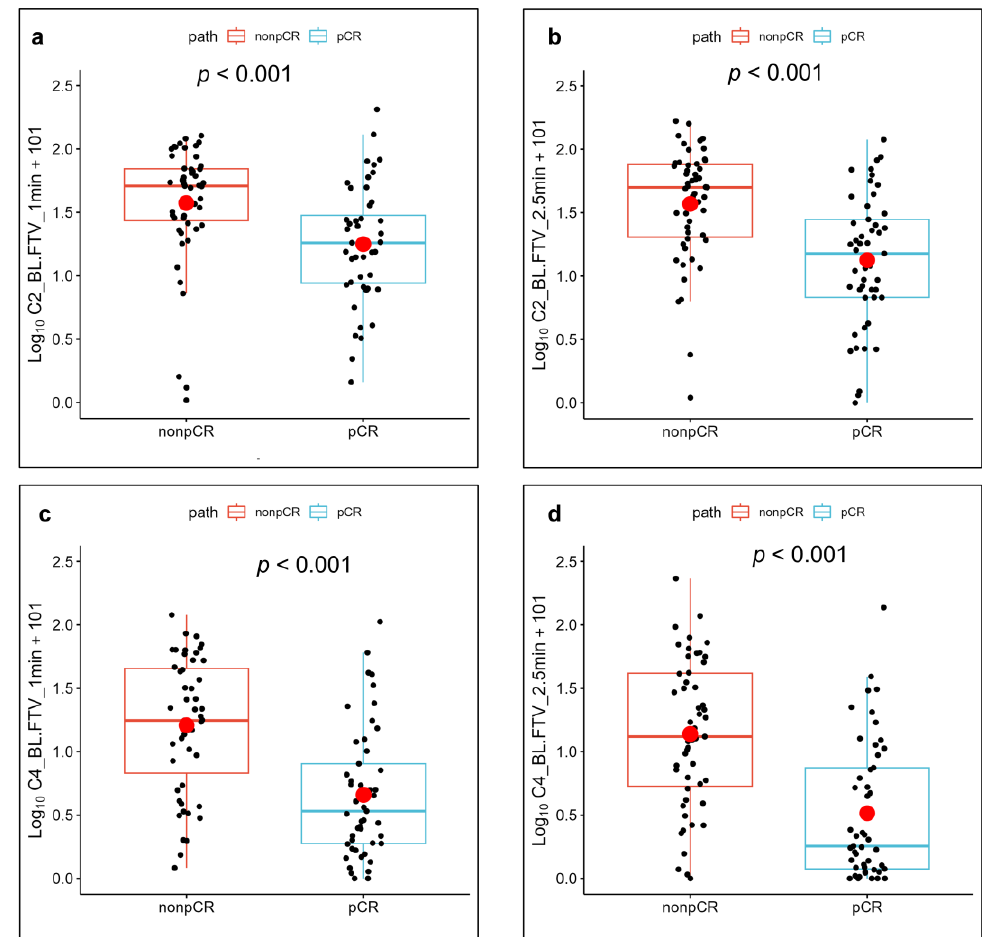
Figure 6. Relative changes in the functional tumor volume (FTV) measurements and their mean (red circle) corresponding to optimal percentage enhancement (PE) and signal enhancement ratio (SER) for patients with pathologic complete response (pCR) and non-pCR. Plots correspond to ( a , b ) changes in FTV from baseline (BL) to after the second cycle of neoadjuvant systemic therapy (NAST) (C2), measured on images obtained 1 min ( a ) and 2.5 min ( b ) after contrast agent injection; and ( c , d ) changes in FTV from baseline to after the fourth cycle of NAST (C4), measured on images obtained 1 min ( c ) and 2.5 min ( d ) after contrast agent injection.